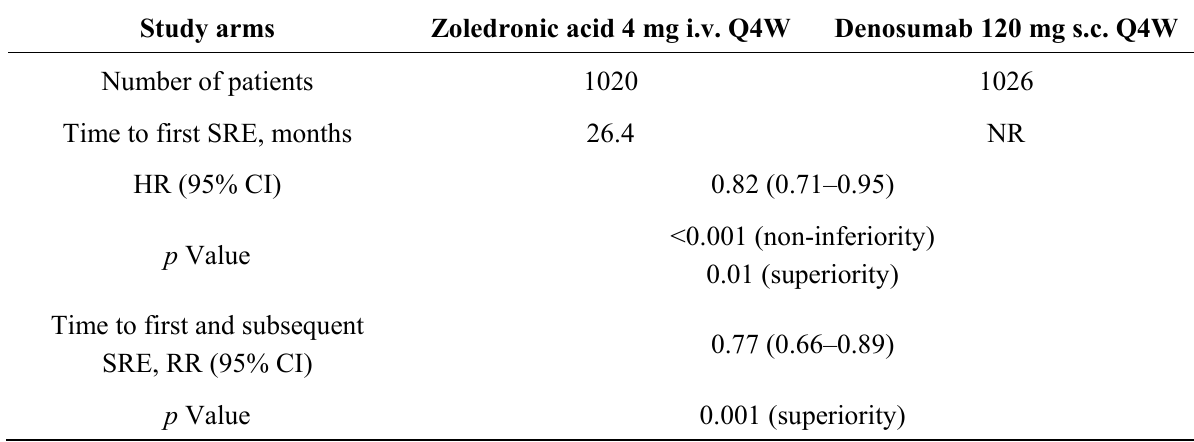
Table 1. Results from a phase 3, randomised, double-blind study comparing denosumab with zoledronic acid for the prevention of skeletal-related events in patients with bone metastases associated with breast cancer